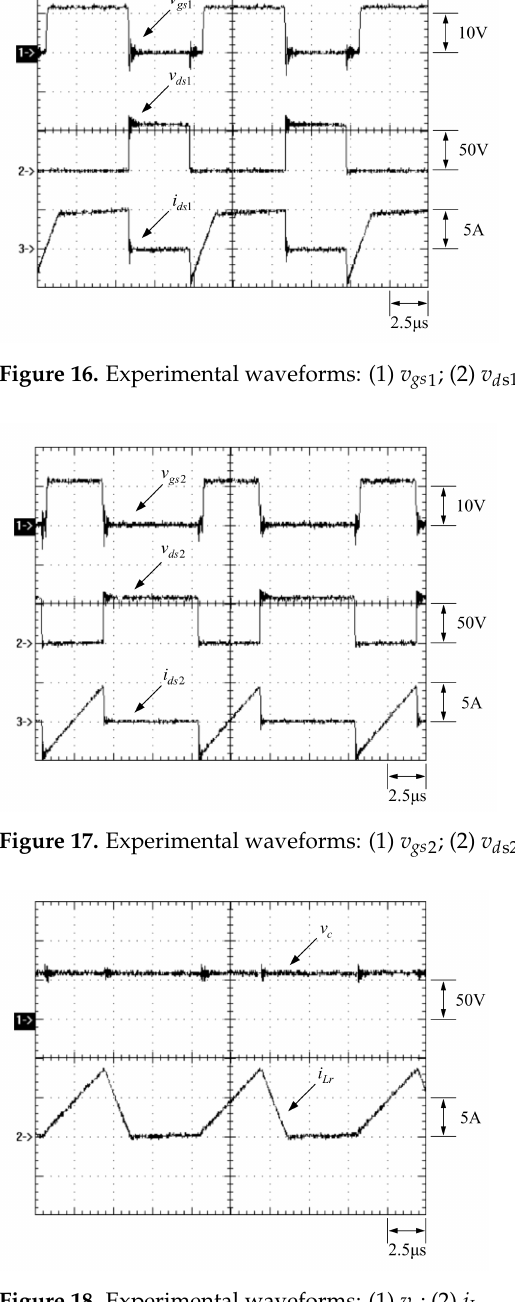
Figure 18. Experimental waveforms: (1) v c ; (2) i Lr